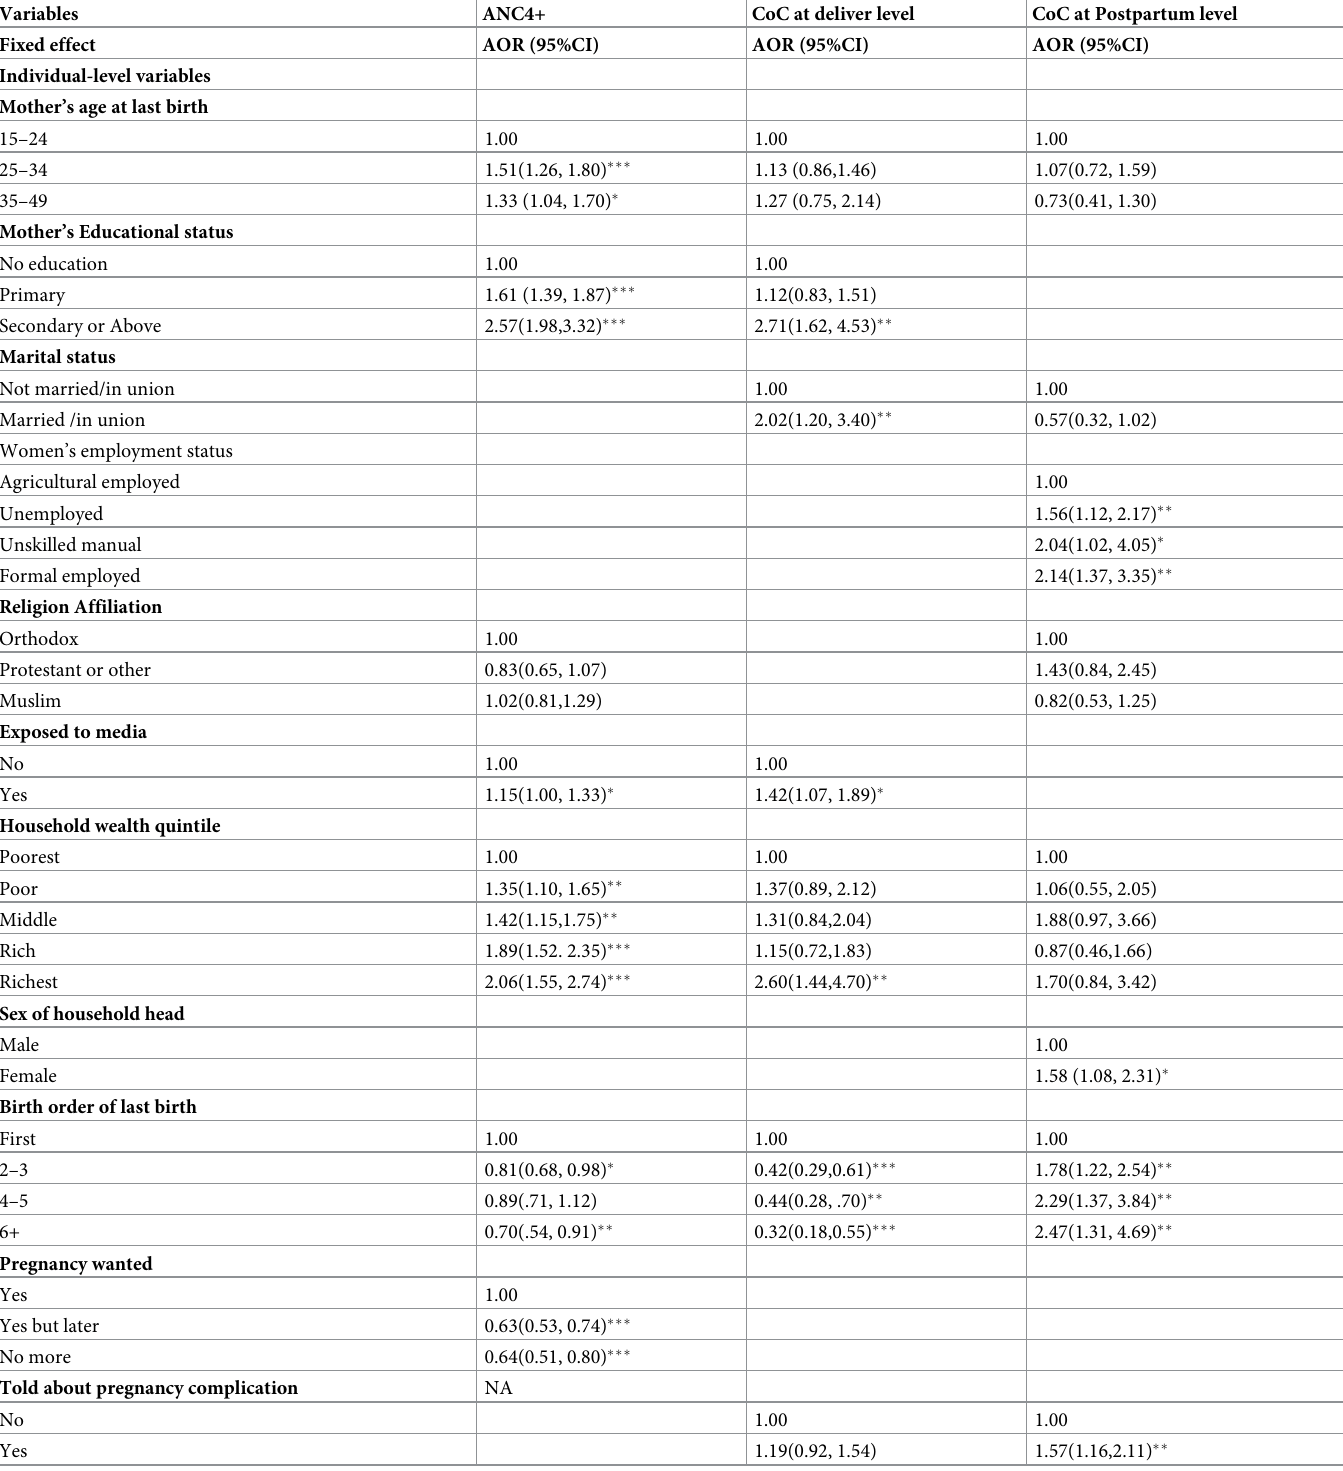
Table 5. Multivariate multilevel logistic model of achievement of ANC4+ visits; CoC at delivery level; and CoC at postpartum level and adjusted odds ratio with a 95% confidence